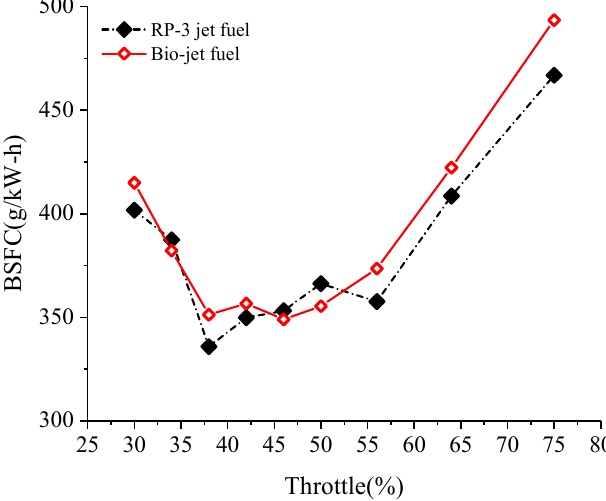
Figure 7. Variation of BSFC against throttle opening.